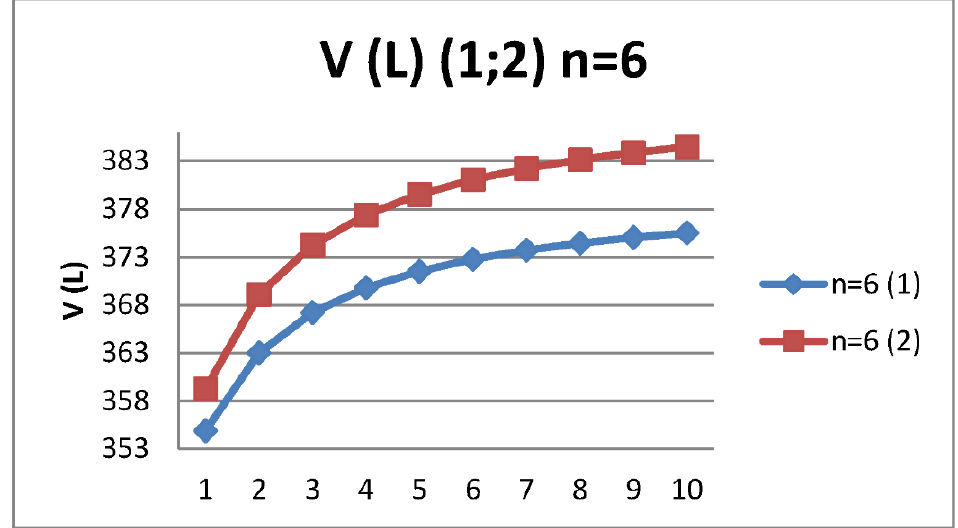
Figure 5. Dependence of the company value, V , on leverage level L in the cases of payments of tax on profit at the end of the year (1) and in the beginning of the year (2) for six-year company.